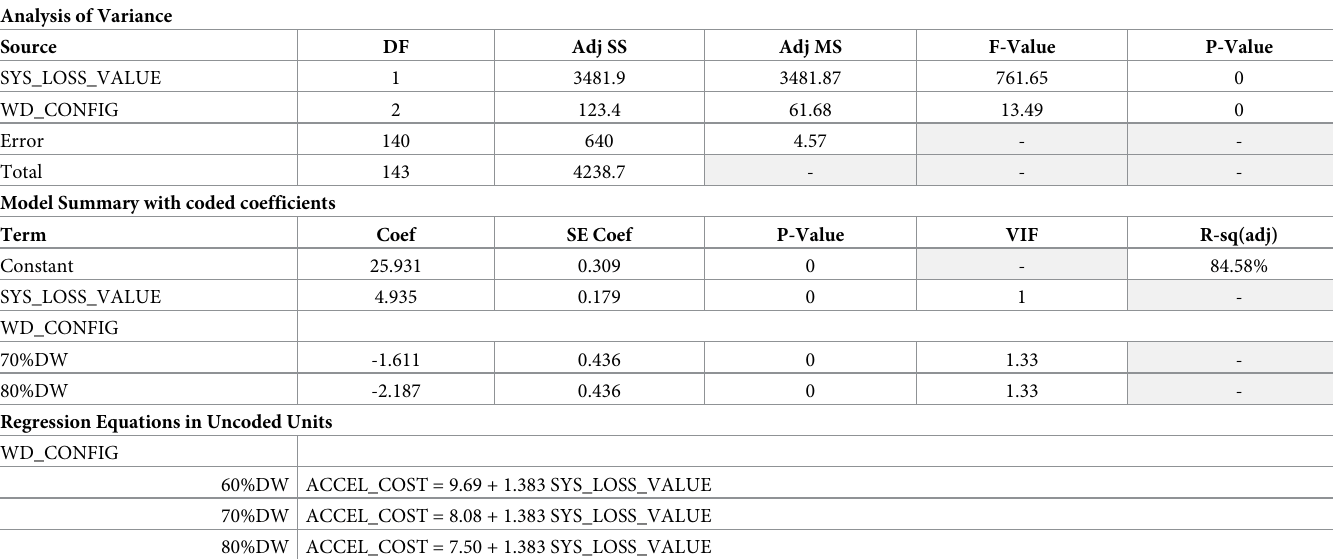
Table 7. Accel cost: Fixed-wheel turn.